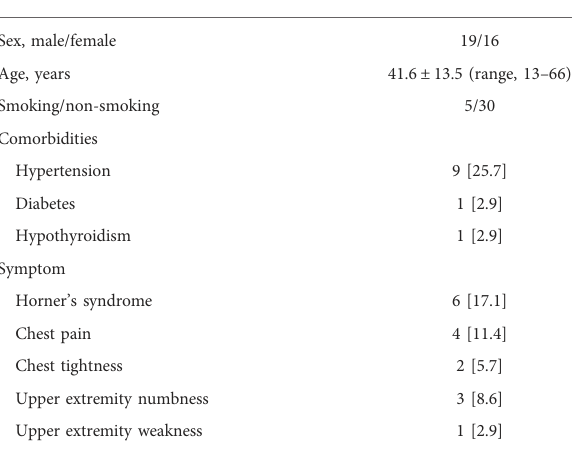
TABLE 4 Postoperative characteristics and pathological